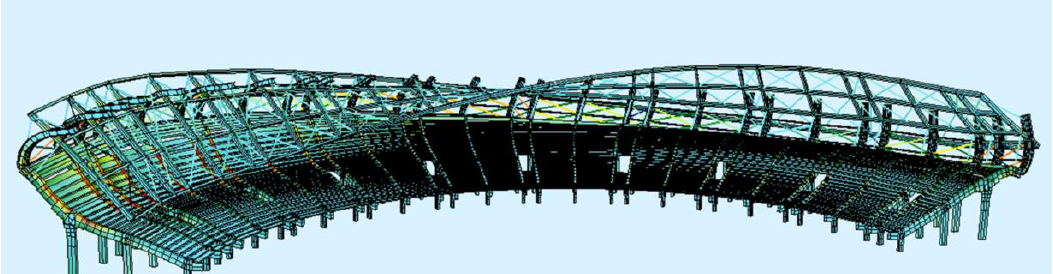
Figure 26. The first numerical form of natural vibrations of the stand after structural tuning .